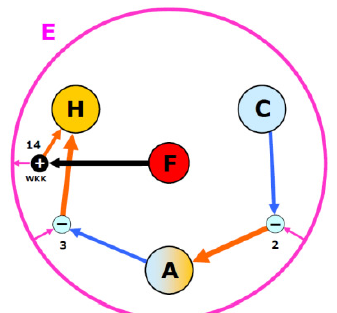
Fig. 10. – Hybrid system: